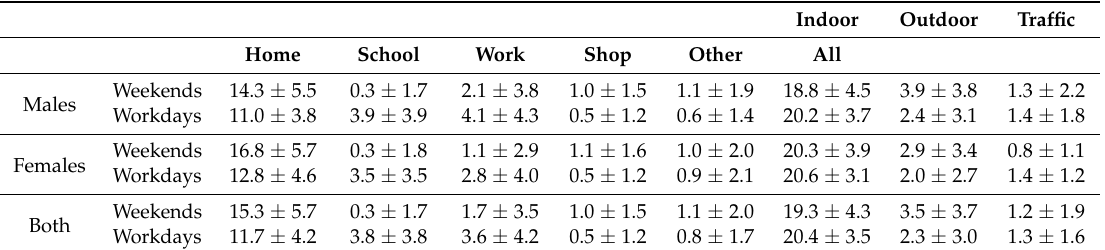
Table 1. Residence time (hours: average ± std) with respect to gender.